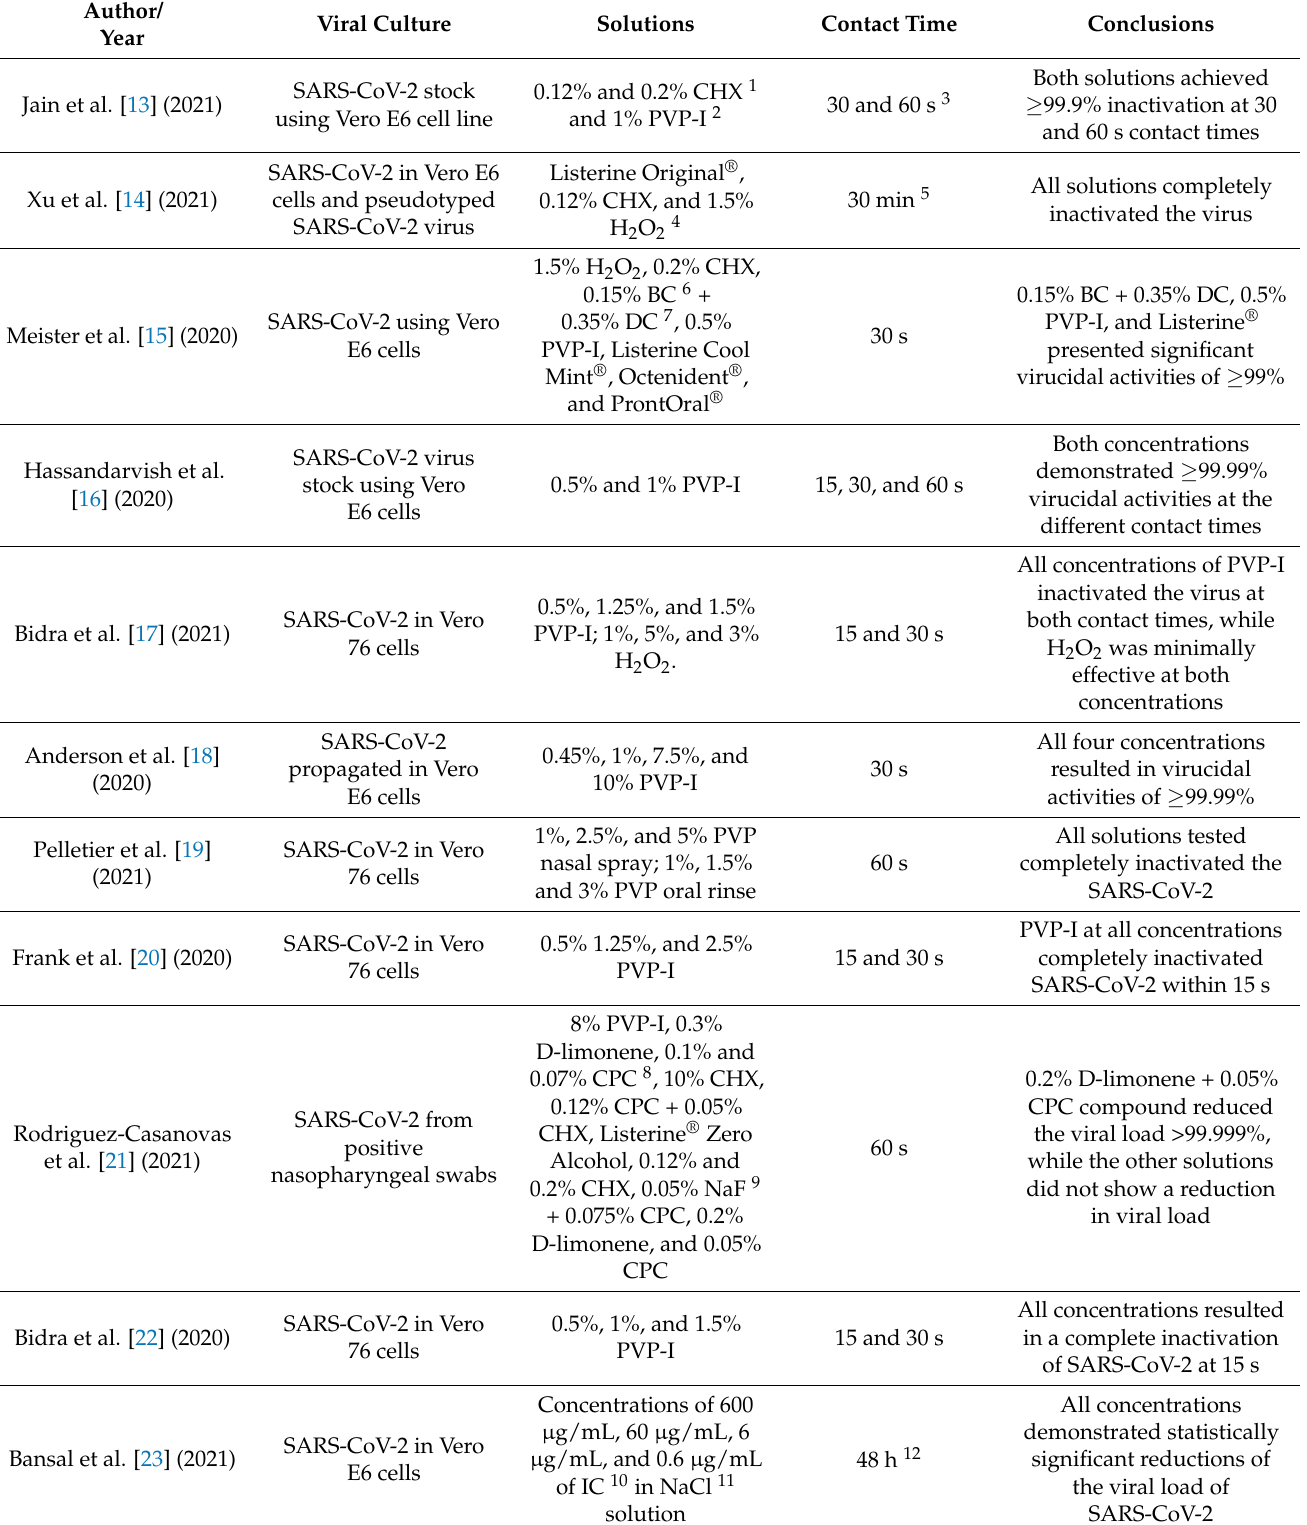
Table 1. Summary of the in vitro